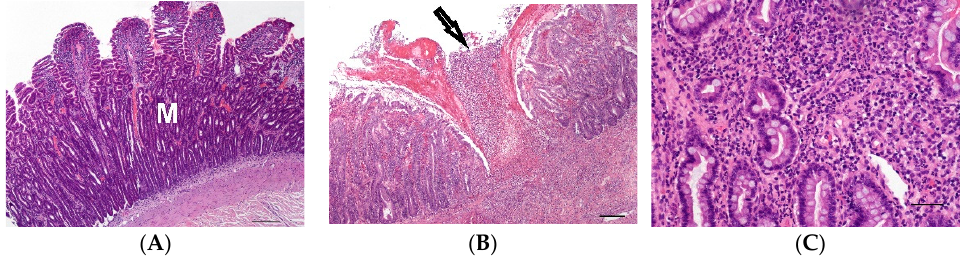
Figure 2. ( A ) Moderate lymphoplasmacytic infiltration and villus atrophy of the mucosa (M) of the jejunum of a 2-year-old male Magyar Vizsla; (HE, bar = 200 µm). ( B ) Focal severe acute ulcerative inflammation of the mucosa (arrow) and submucosa of the ileum in transmural intestinal foreign body disease of a 4-year-old male castrated Belgian Shepherd; (HE, bar = 200 µm). ( C ) Diffuse moderate infiltration of the large intestinal mucosa with lymphocytes, plasma cells and neutrophils in the large intestine of a 4-year-old female Rottweiler; (HE, bar = 50 µm).